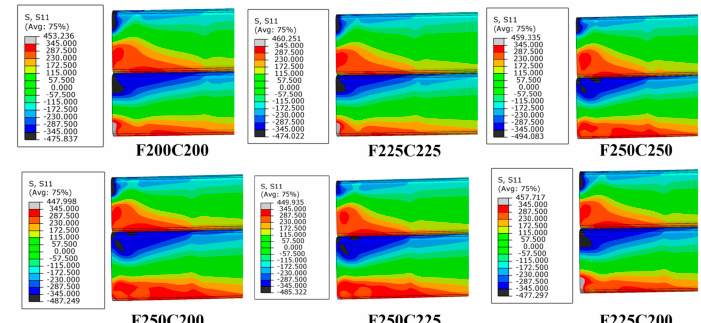
Figure 28. Stress distribution of twin beams with different height.